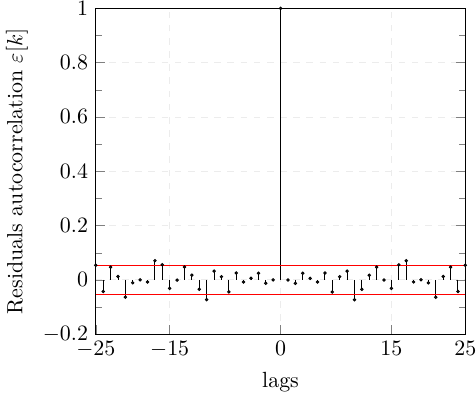
Figure 7. Auto-correlation of ARFIMA model